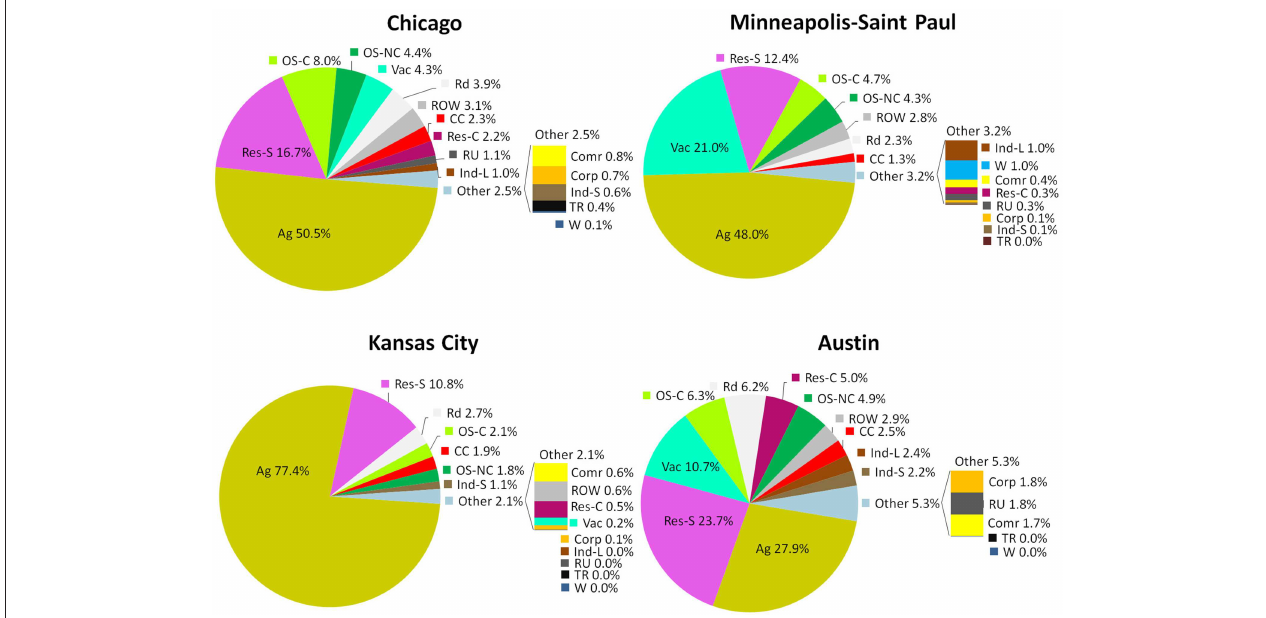
FIGURE 6 | Proportion of grass/shrub land cover (“plantable space”) categorized by land use category for each metropolitan area. Agriculture and Residential-single family make up the highest and second-highest proportions in almost all of the metropolitan areas. Austin was limited to one county.